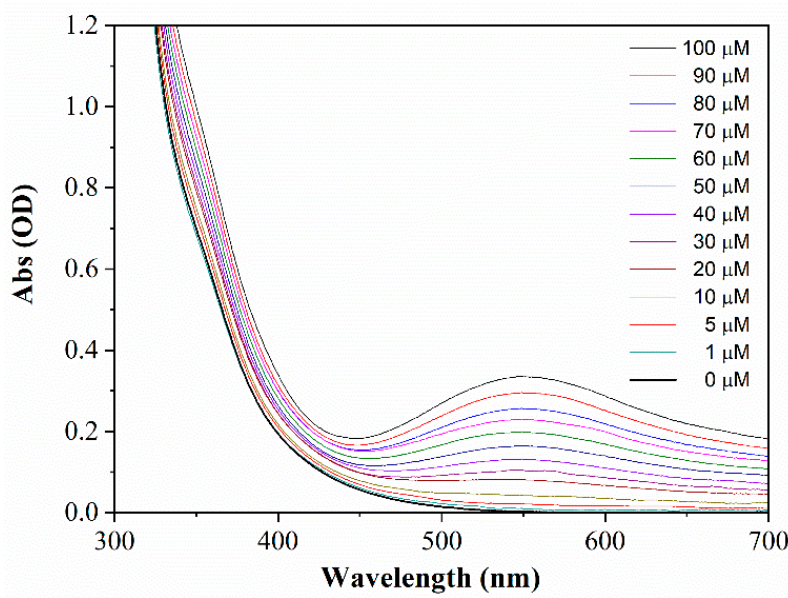
Figure 4. UV-vis absorption spectra of N-CDs-W-THF upon the addition of Cr(VI) ions at different concentrations.